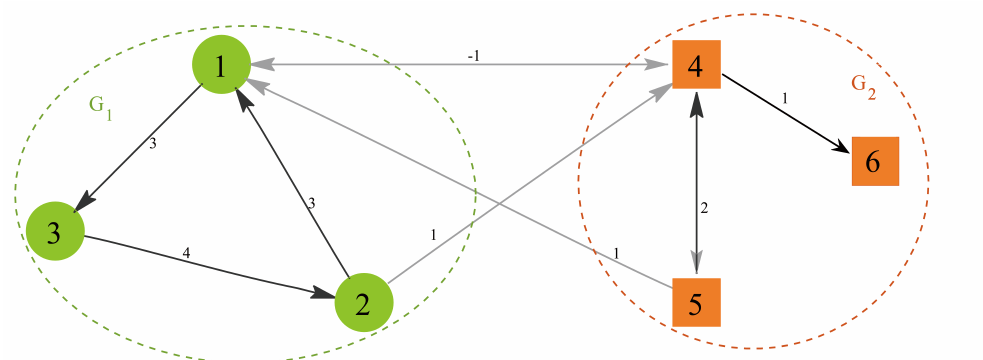
Figure 8. Example 1 of the balanced couple topology for two groups.